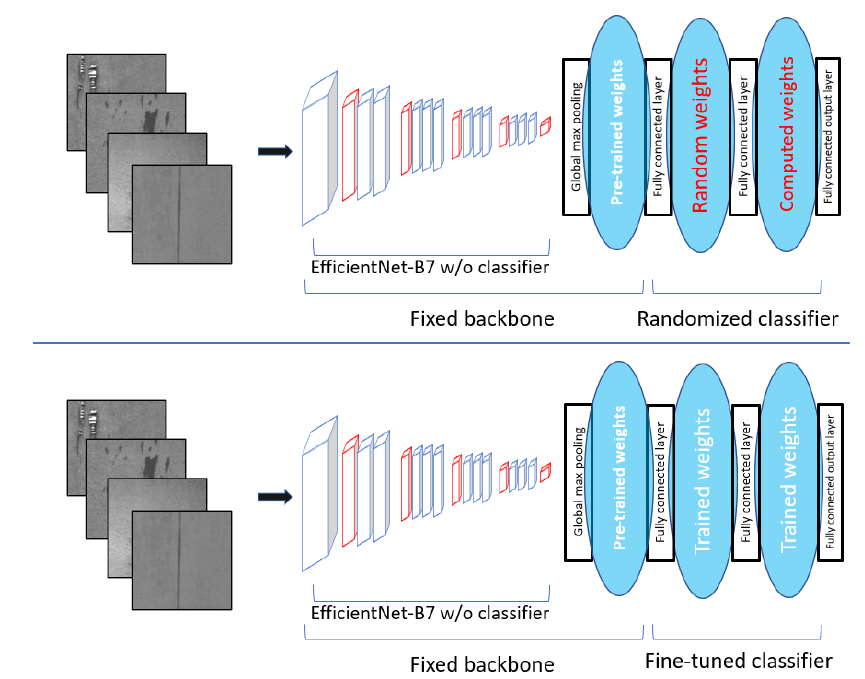
Figure 5. The illustration of the Effnet+RC and the EffNet+FtC networks. While the structures are similar, there is a big difference as the former should not be trained with backpropagation.